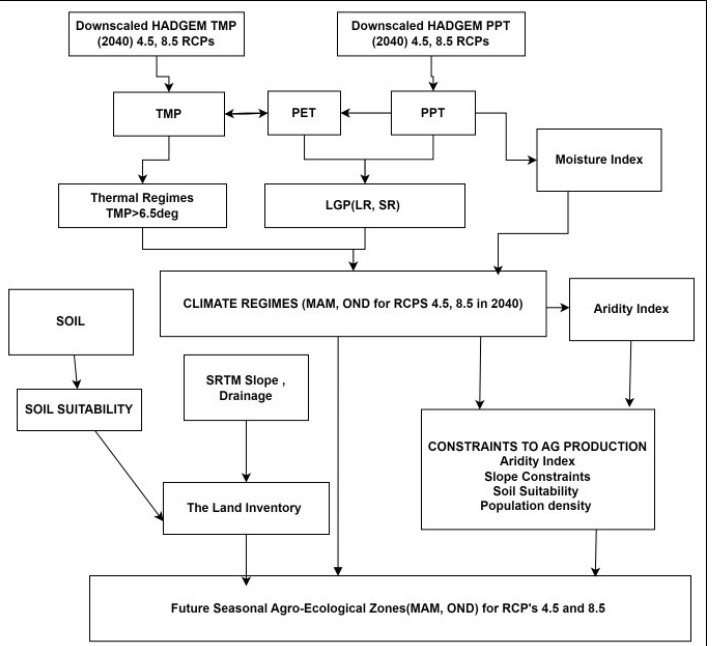
Figure 1. Methodology: An illustration of the approach used for mapping future agro-ecological